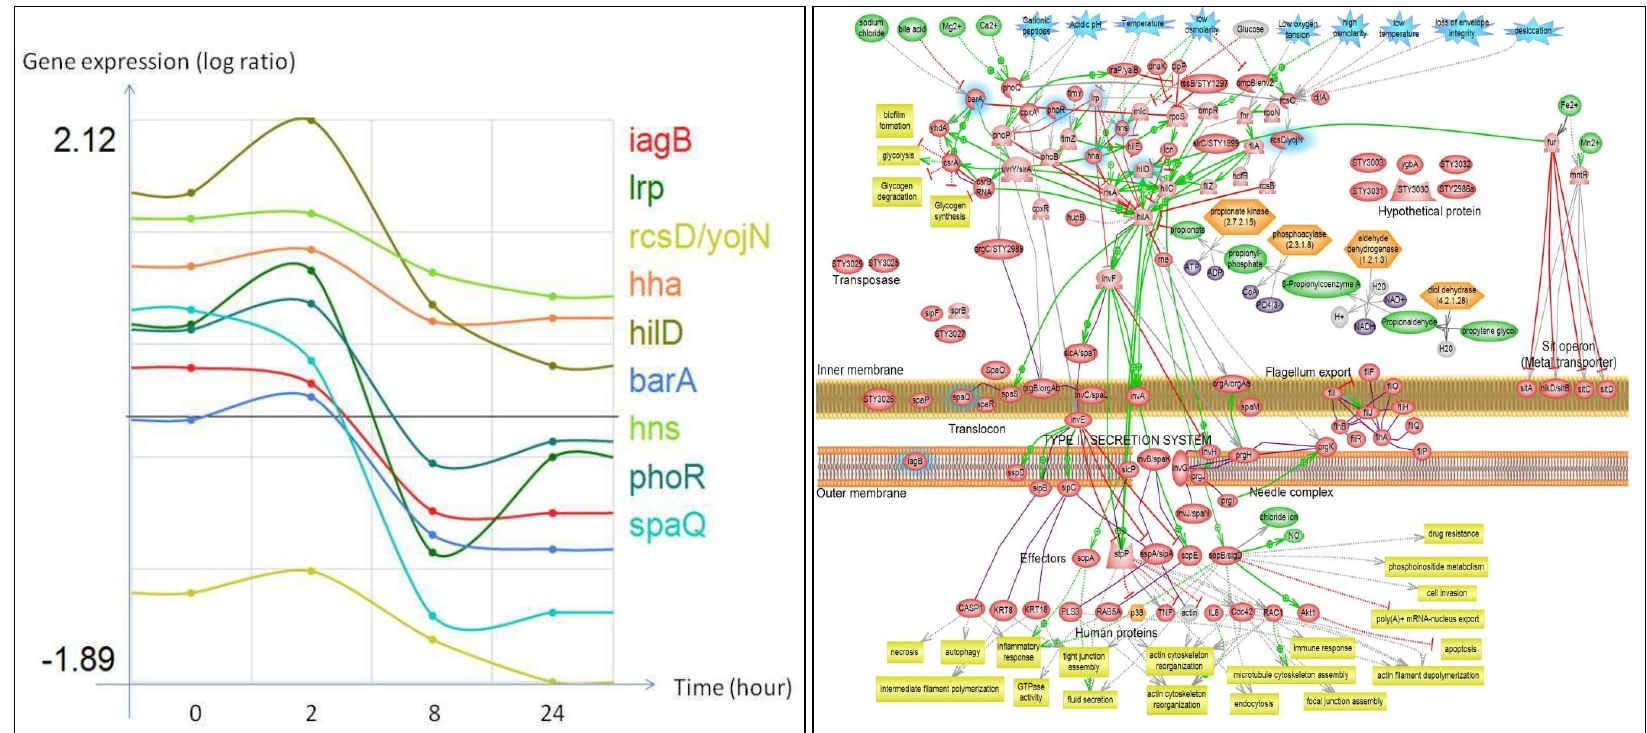
Figure 11b: Cluster 1B. SPI-1 genes form two distinct gene expression clusters in the time-course of Salmonella infection of macrophages. First cluster is shown on Figure 11a. Expression profile of second cluster is shown here. This cluster consists of genes which have positive correlation. It appears that this group of genes plays a significant role in the signaling pathway (left). The expression profile corresponds to the proteins as highlighted in blue. It shows that in this cluster, the sensor and transcriptional factors are positively correlated (right). Environmental sensors barA, rcsD and phoR have expression profile similar to lrp and hilD profile. This analysis also shows that hilD expression is controlled by lrp activity through hns global transcription regulator. Both hns and hha transcription factor are controlled by low osmolarity suggesting that this environmental signal is sensed by Salmonella during the macrophage